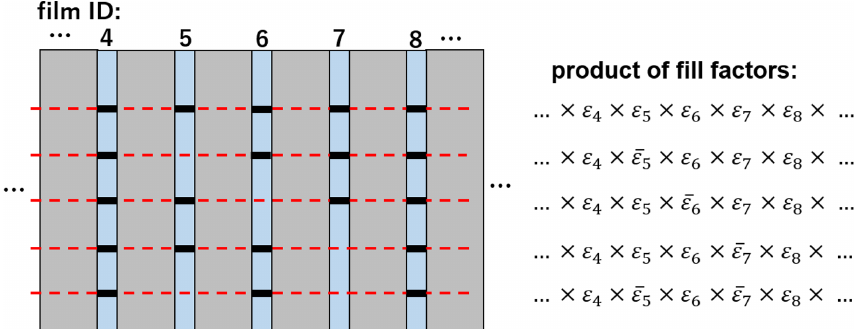
Figure 10. Example of all hit patterns and the products of fill factors in Eq. (4) when base tracks are found in film ID numbers 4 and 8. The red lines indicate the reconstructed tracks and the short black lines represent the base tracks found in the films.